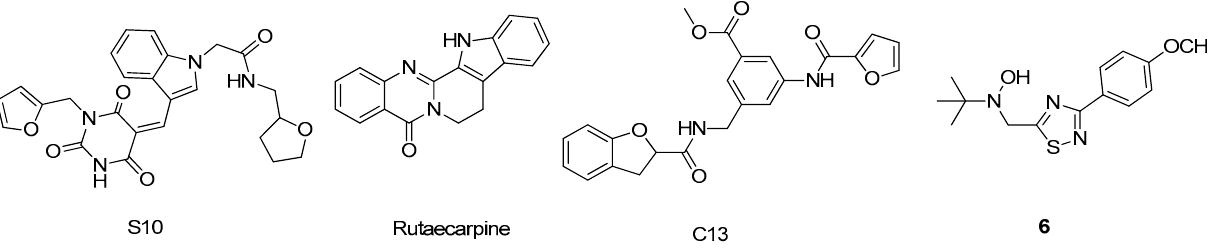
Figure 11. Structures of the studied caspases inhibitors.